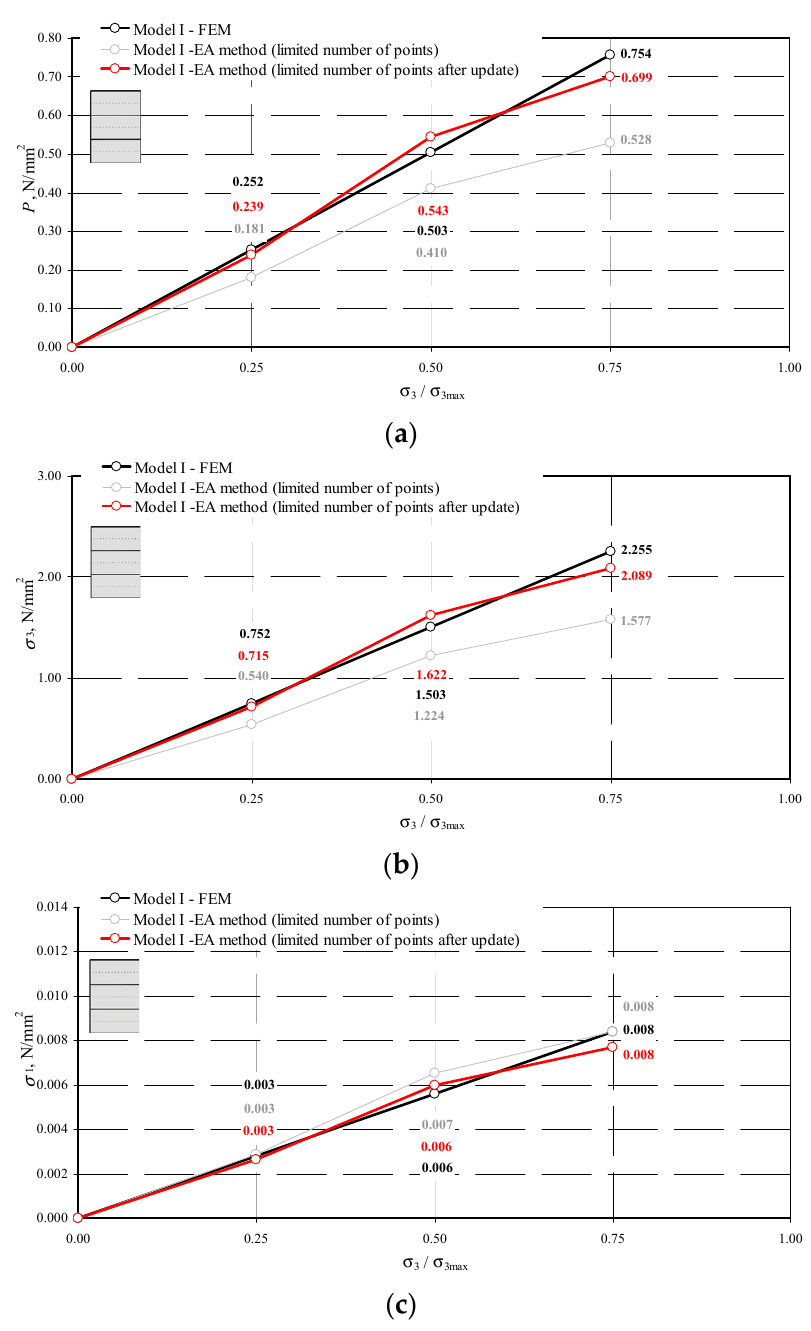
Figure 20. Comparison of stress values determined by the NDT and FEM methods for the model I-1: ( a ) mean hydrostatic stress; ( b ) normal stress perpendicular to the plane of bed joints; ( c ) normal stress parallel to the plane of bed joints.